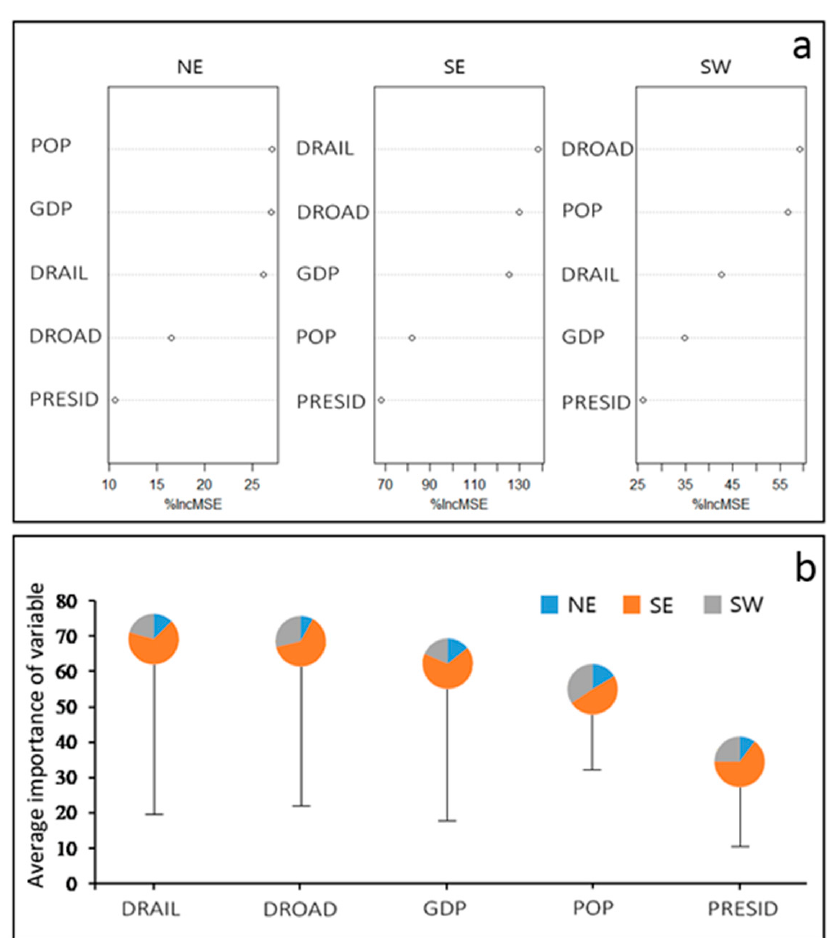
Figure 4. Variable importance measures (%IncMSE- Increase in Mean Square Error) of human factors from Random Forests in different regions ( a ). Comparison of the relative importance of variables to fire occurrence (pie charts) and the relative importance of each variable among the three regions (different portions within each pie chart) ( b ). The bars below each pie chart represent the standard deviation of the relative importance of each variable amongst three forest ecosystems. %IncMSE ( x -axis) quantifies the importance of a variable by measuring the change in prediction accuracy when the values of the variable are randomly permuted compared with the original observations. Abbreviated variable names are described in Table 2.